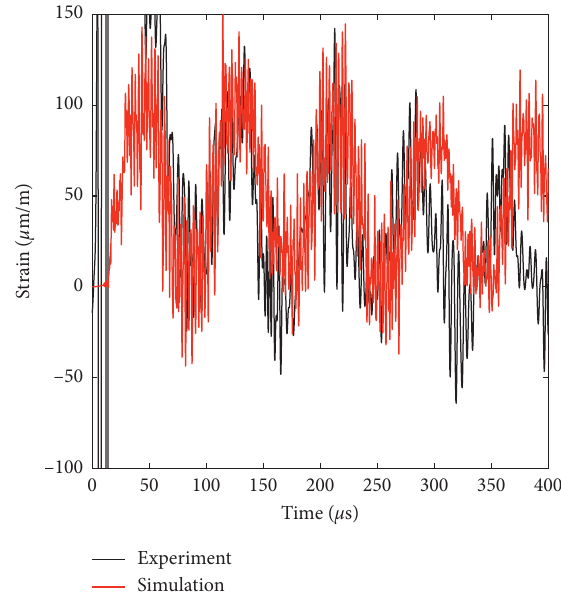
Figure 19: Longitudinal strain for shot 128, probed at a length of 154mm on the bottom face of the second specimen. The numerical model with Young’s modulus of 194GPa and the multilinear hardening